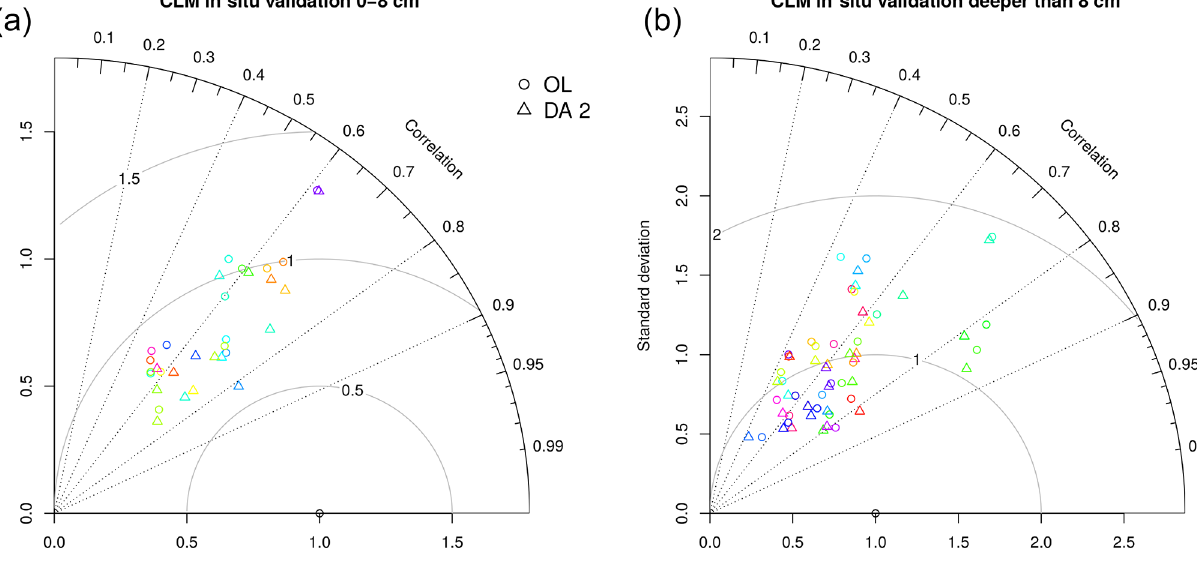
Figure 3. Taylor diagrams showing assimilation impact on top-layer soil moisture, defined as 8cm soil depth (a) , and lower-level soil mois- ture (b) in terms of correlation coefficient R , standard deviation and normalised root mean square error (RMSE) for all in situ measurement sites. Measurements at multiple depths are not